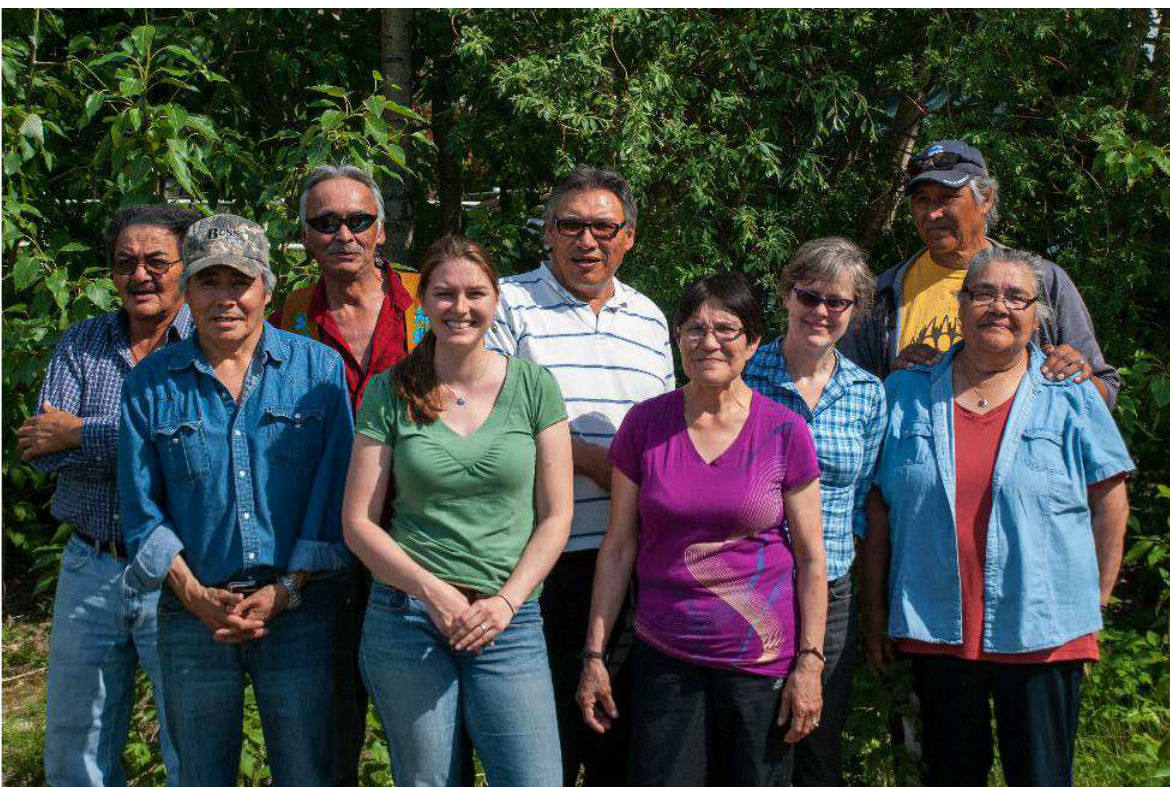
Figure A1.1. We discussed traditional knowledge themes, language, and genetic data with a local group of experts (advisory group, including co-authors) in two separate 3-day meetings to clarify and develop important concepts and themes related to caribou populations in the Saht region and Nahanni National Park Reserve of the Northwest Territories, Canada. Advisory group members June 2014 in Tul t'a, Northwest Territories: Gordon Yakeleya, Frederick Andrew, Michael Neyelle, Jean Polfus, Walter Bayha, Camilla Rabisca, Deborah Simmons, Michel Lafferty, and Judy